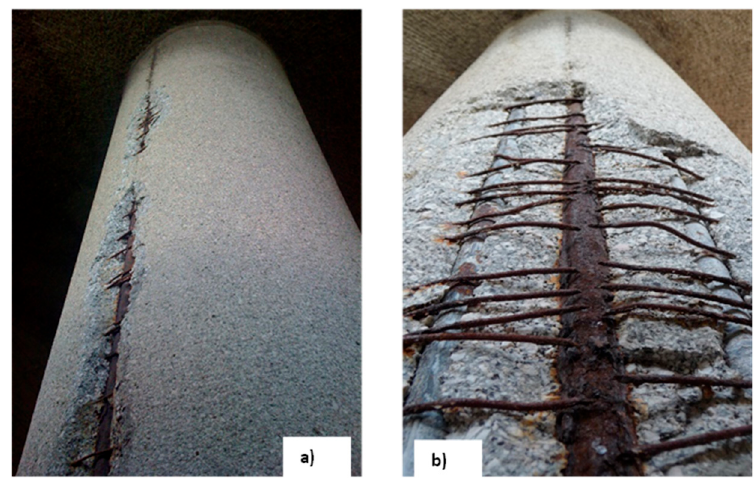
Figure 4. Details of the columns at the ground floor: ( a ) spalled concrete cover, and ( b ) corroded steel reinforcement.